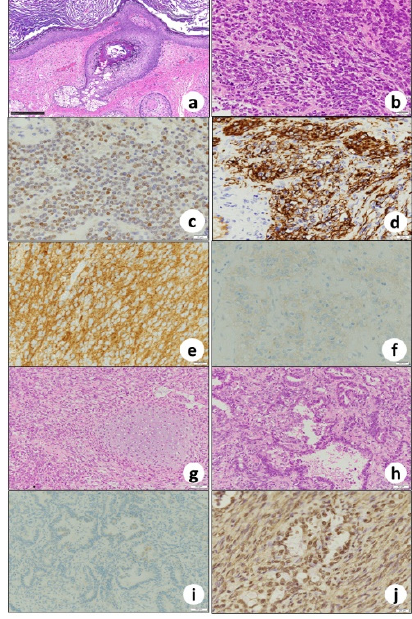
Figure 4. The cystic lesion is lined with ( a ) epidermis with skin appendages. Histopathology and immunohistochemistry of ( b ) small round-cell tumor nuclear-positive for ( c ) NKK2.2, membranous- positive for ( d ) CD56, cytoplasmic-positive for ( e ) GFAP, and weakly membranous-positive for ( f ) CD99, suggesting PNET. Histopathology of ( g ) spindle cell sarcoma component, partly differentiated to chondrosarcoma and ( h ) non-specific adenocarcinoma component. Adenocarcinoma component is negative for ( i ) anti-PAX8 but positive for ( j ) ARID1A. ( a , b , g , h ) Hematoxylin and eosin staining, immunohistochemistry of ( c ) NKK2.2, ( d ) CD56, ( e ) GFAP, ( f ) CD99, ( i ) PAX8, and ( j ) ARID1A. Bars: ( a ) 250 μ m; ( b – f ) 20 μ m; and ( g – j ) 50 μ m.